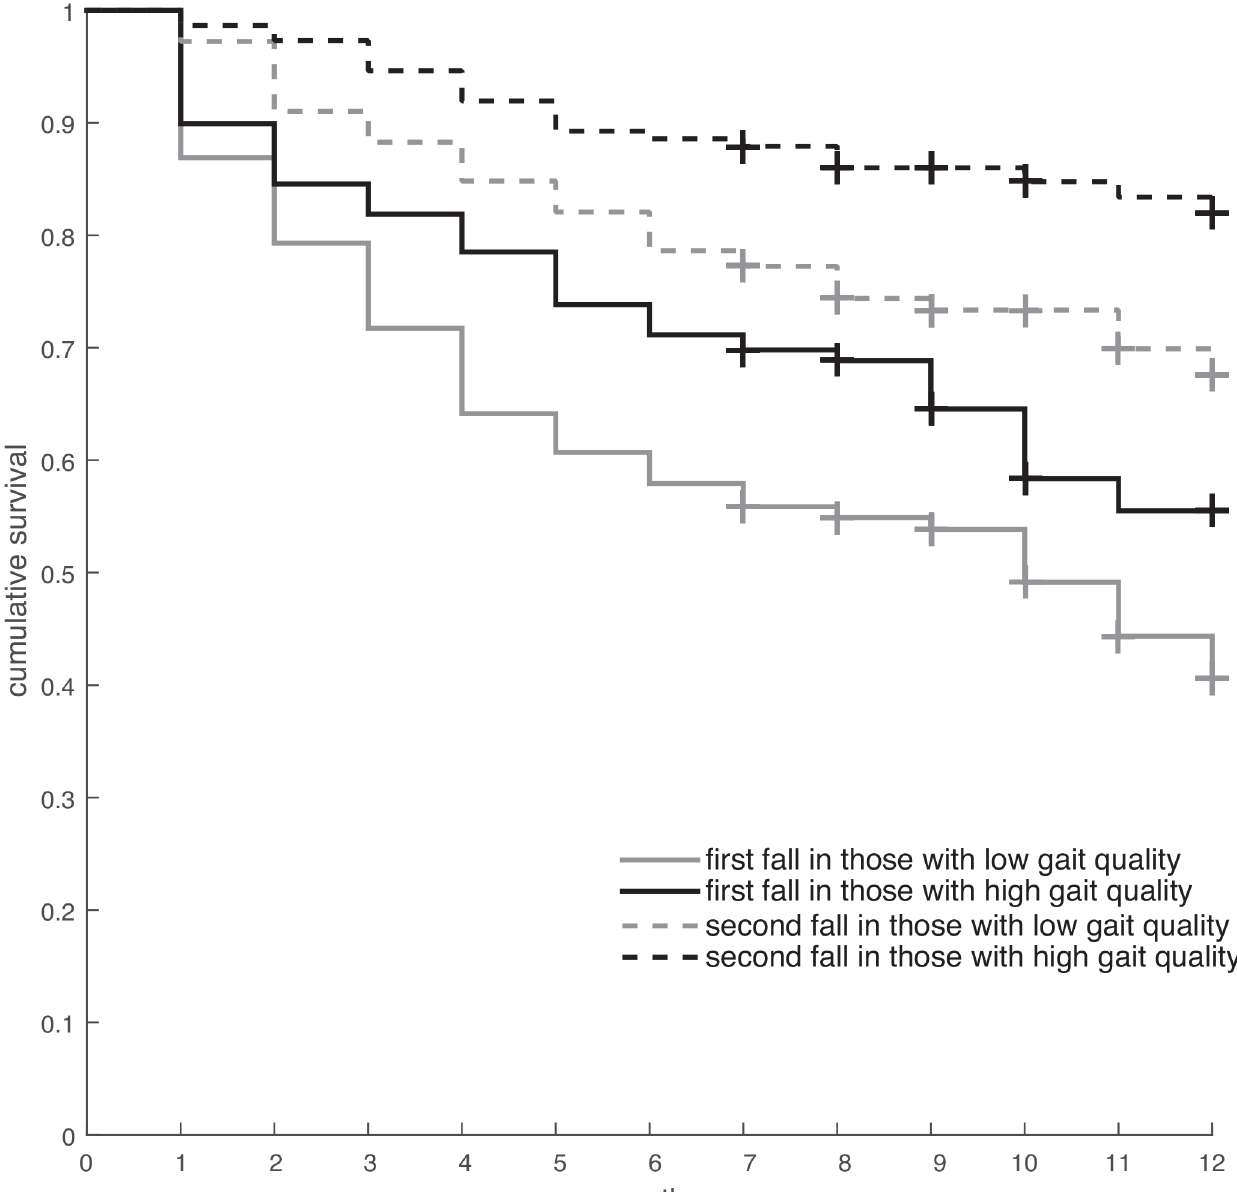
Fig 2. Kaplan-Meier curve depicting survival time for people with below and above average gait quality. + indicates censoring.